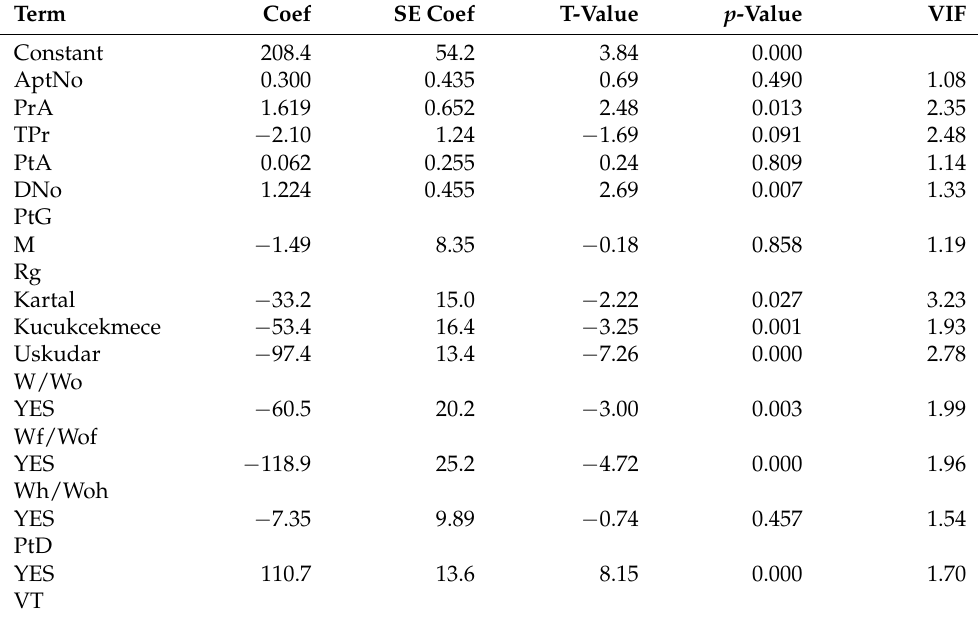
Table A3. The values of terms coefficient